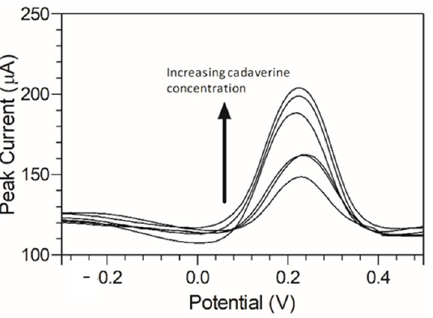
Figure 6. Anodic peak differential pulse voltammograms of cadaverine (3–150 µ g/mL) using MWCNT/DAO/EDC-NHS/GA SPE with resulting peak current range of 32.22–43.13 µ A vs. Ag/AgCl reference electrode in supporting Britton–Robinson buffer at pH 6.0.